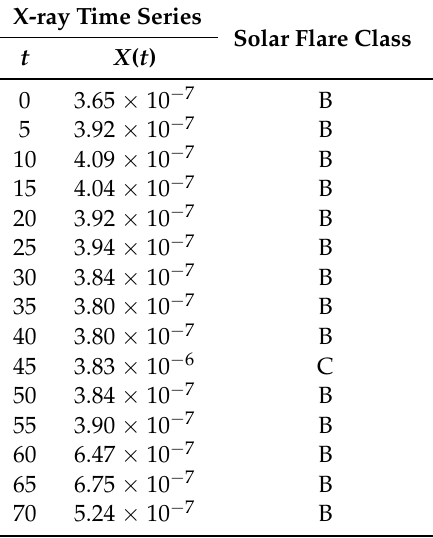
Table 1. Example of dataset tuples- XTS ( t